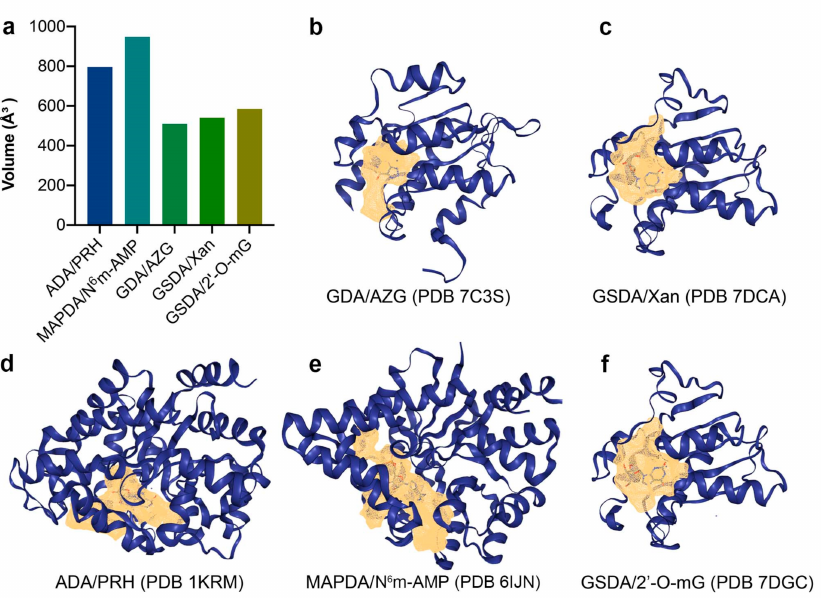
Figure 7. The comparison of the ligand-binding pockets of the purine-metabolic enzymes: GDA, GSDA, ADA, and MAPDA. ( a ) The volume sizes of the ligand-binding pockets. ( b – f ) The three- dimensional structures of GDA, GSDA, ADA, and MAPDA, with their catalytic pockets shown by the yellow mesh and the ligands shown by sticks (PDBs 7C3S, 7DCA, 7DGC, 1KRM, and 6IJN). PRH: 6-hydroxy-1,6-dihydropurine riboside, N 6 m-AMP: N 6 -methyl-AMP; AZG: 8-azaguanine; Xan: xanthosine; 2 (cid:48) -O-mG: 2 (cid:48)